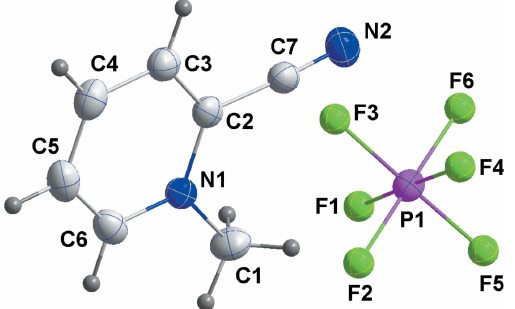
Figure 3 Perspective view of 3 with labeling scheme and 50% probability ellipsoids.